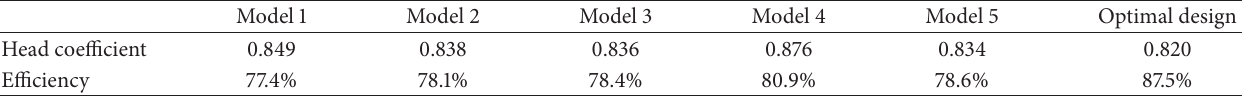
Table 5: The estimated performance of 6 impellers at design